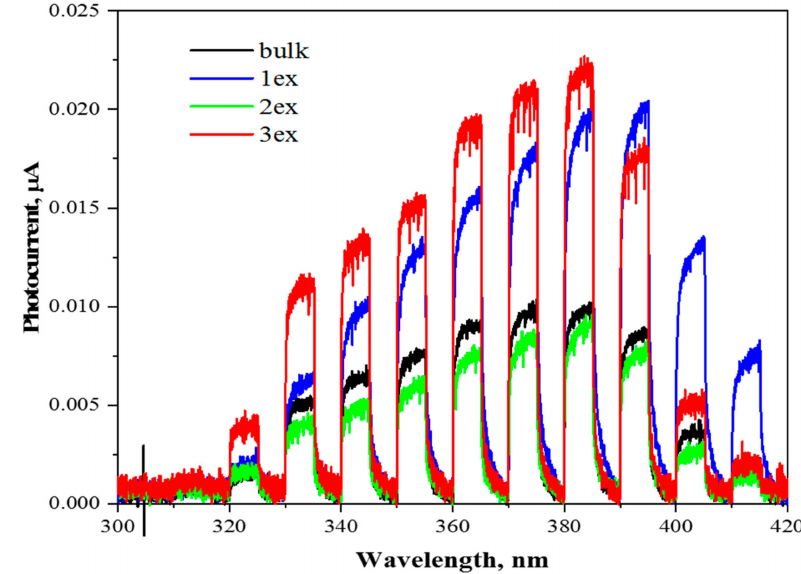
Figure 9. Photocurrent responses of the bulk and exfoliated (1ex, 2ex and 3ex) g-C 3 N 4 under external potential of 1